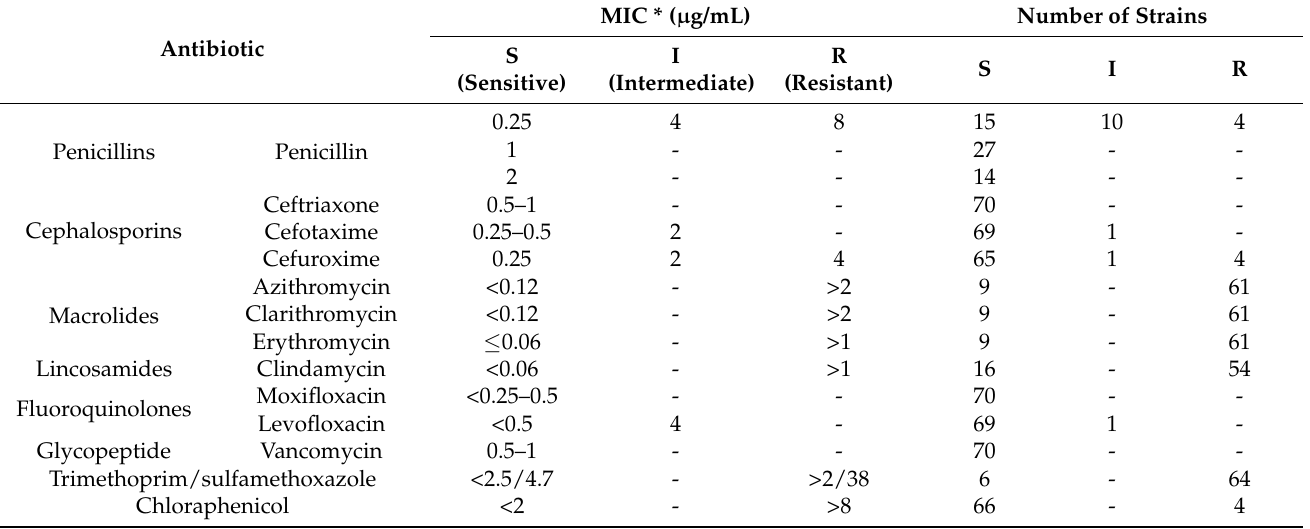
Table 2. Antibiotic resistance of Streptococcus pneumoniae strains.